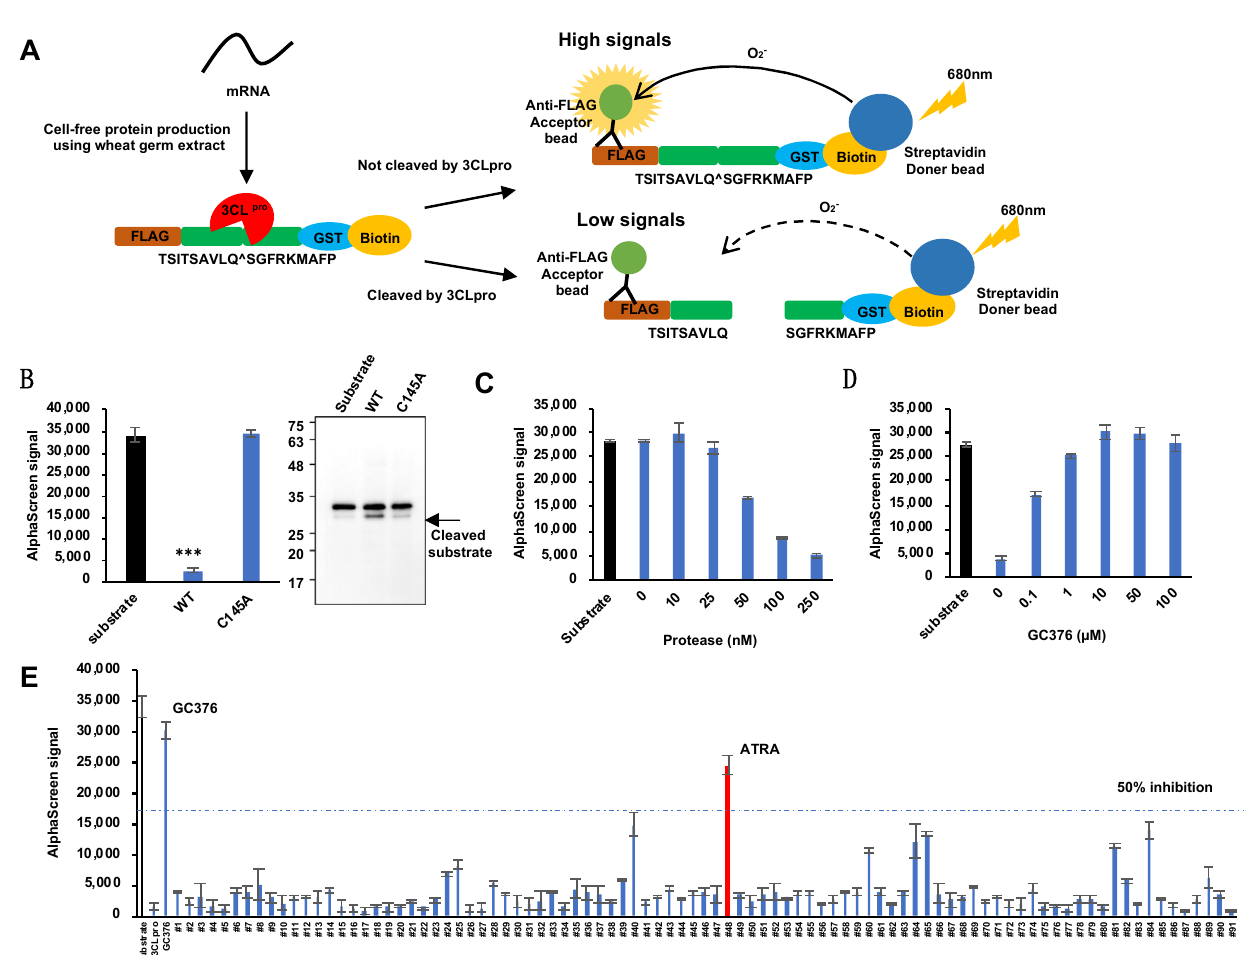
Figure 1. Development of SARS-CoV-2 3CLpro inhibitor screening assay using AlphaScreen. ( A ) Schematic representation of AlphaScreen-based assay for SARS-CoV-2 3CLpro enzymatic activity. A high signal is detected when the substrate is not cleaved by 3CLpro, and the signal becomes weaker when the substrate is cleaved. ( B ) Results of an enzymatic assay using wild-type SARS-CoV-2 3CLpro and its inactive mutant, C145A. 3CLpro decreases the signal when the substrate is cleaved. Substrate cleavage was also detected by immunoblots. Error bars obtained from duplicate testing. p -value < 0.005 (***). WT-Wild type. ( C ) Optimization of the enzyme assay. A concentration gradient of 3CLpro was reacted with 100 nM of the recombinant substrate and the signal was detected. Error bars obtained from duplicate testing. ( D ) The inhibitory effect of 3CLpro using the known SARS-CoV-2 3CLpro inhibitor GC376. Error bars obtained from duplicate testing. ( E ) Screening of 91 compounds using the 3CLpro enzyme assay. The substrate and enzyme concentration was 100 nM in this experiment. GC376 was used as a positive control. ATRA showed in the red bar. Error bars obtained from duplicate testing.